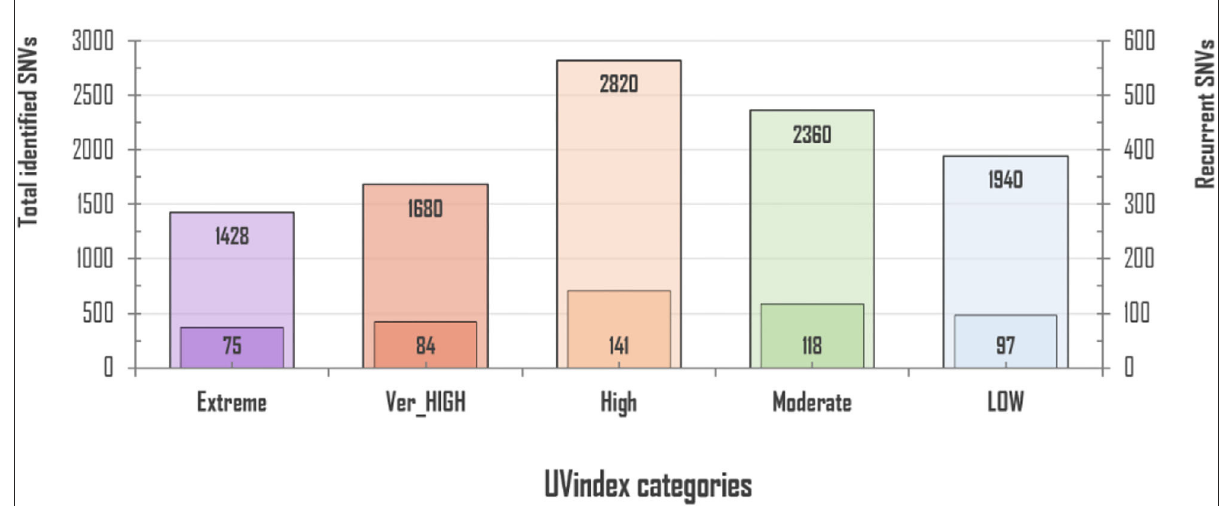
FIGURE1 Total and recurrent SNVs (rcntSNVs) count in all examined 2,500 SARS-CoV-2 genomes, grouped in five distinct UVindex-based categories. For each WHO’s defined UVindex category, the outer bar represents total identified SNVs, whereas the inner short bar represents predicted rcntSNVs.